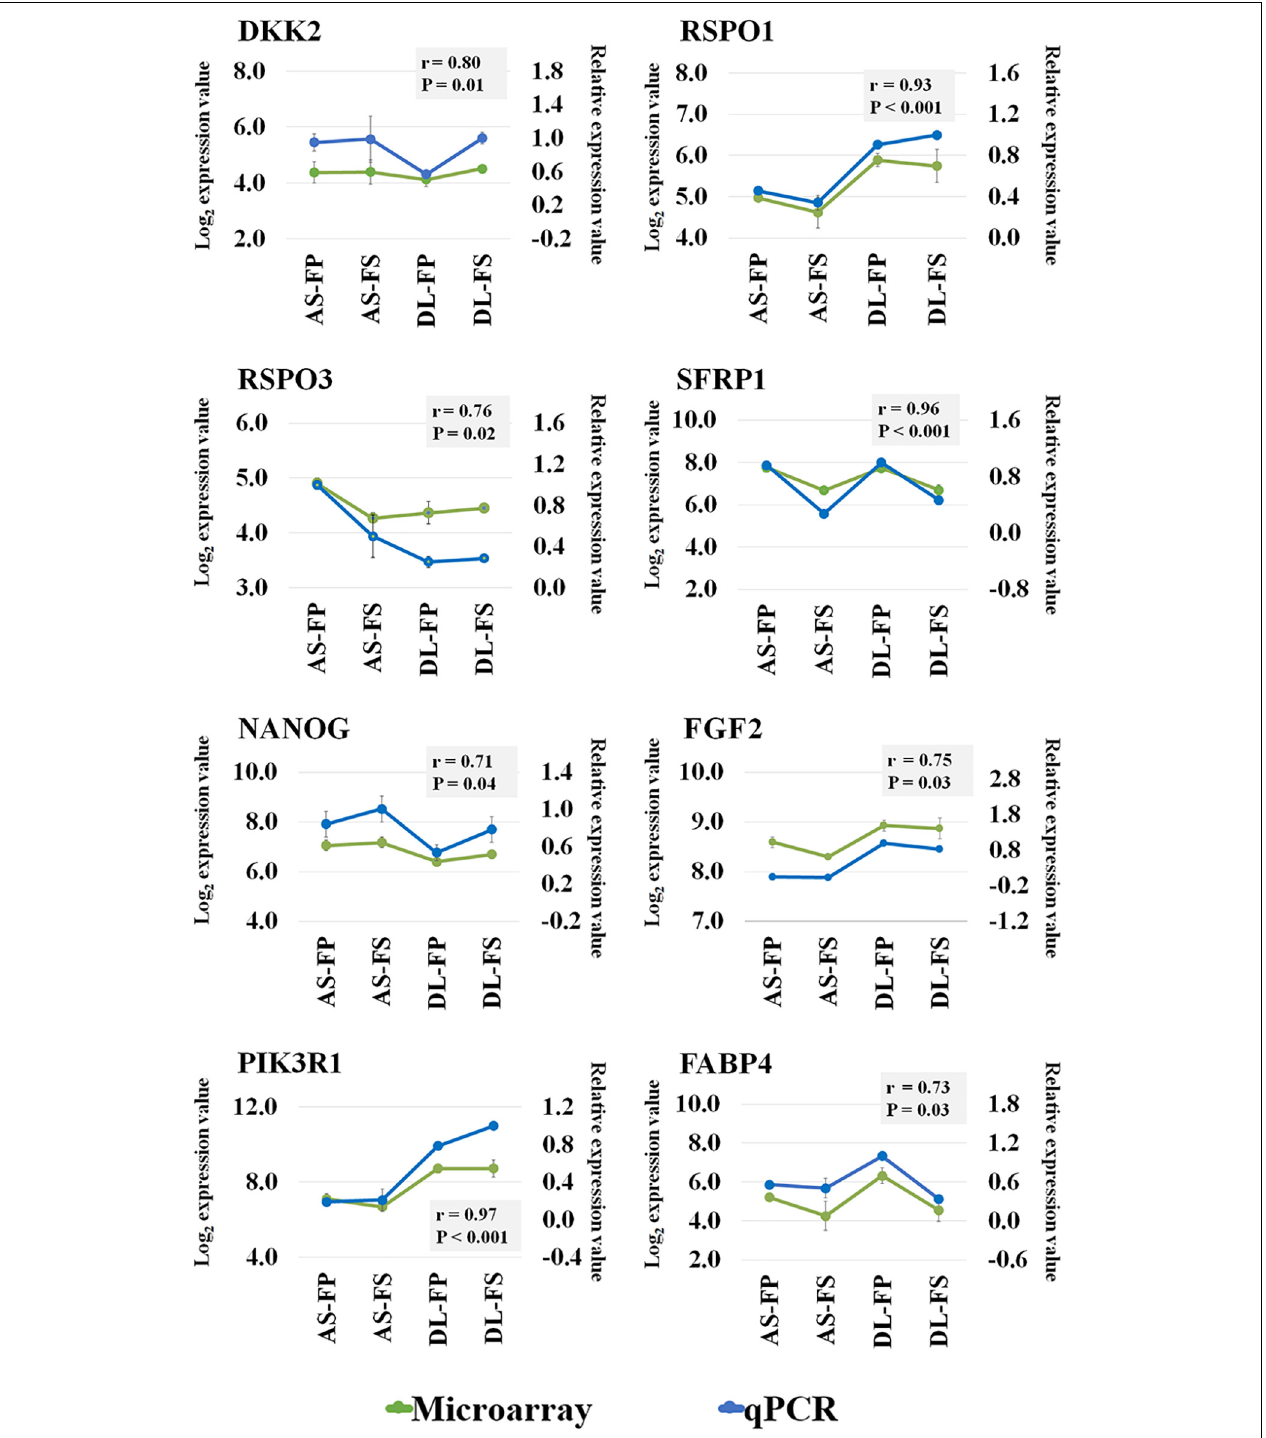
FIGURE 4 | Microarray validation of selected transcripts by RT-qPCR analysis. Correlation coefficient analysis between the microarray and qPCR data for eight genes: DKK2, RSPO1, RSPO3, SFRP1, NANOG, FGF2, PIK3R1, and FABP4 was performed using sas version 9.4. Green line represent the log2 transformed expression value from microarray (the primary y -axis) and blue line represent the relative expression value from qPCR (the secondary y -axis) for each gene are depicted in the same graph with r and P -values. DKK2 ; Dickkopf WNT Signaling Pathway Inhibitor 2, RSPO1 ; R-Spondin 1, RSPO3, R-spondin 3, SFRP1 ; Secreted frizzled-related protein 1, NANOG ; Nanog homeobox, FGF2; Fibroblast growth factor 2, PIK3R1; Phosphoinositide-3-Kinase Regulatory Subunit 1, FABP4; fatty acid binding protein 4.